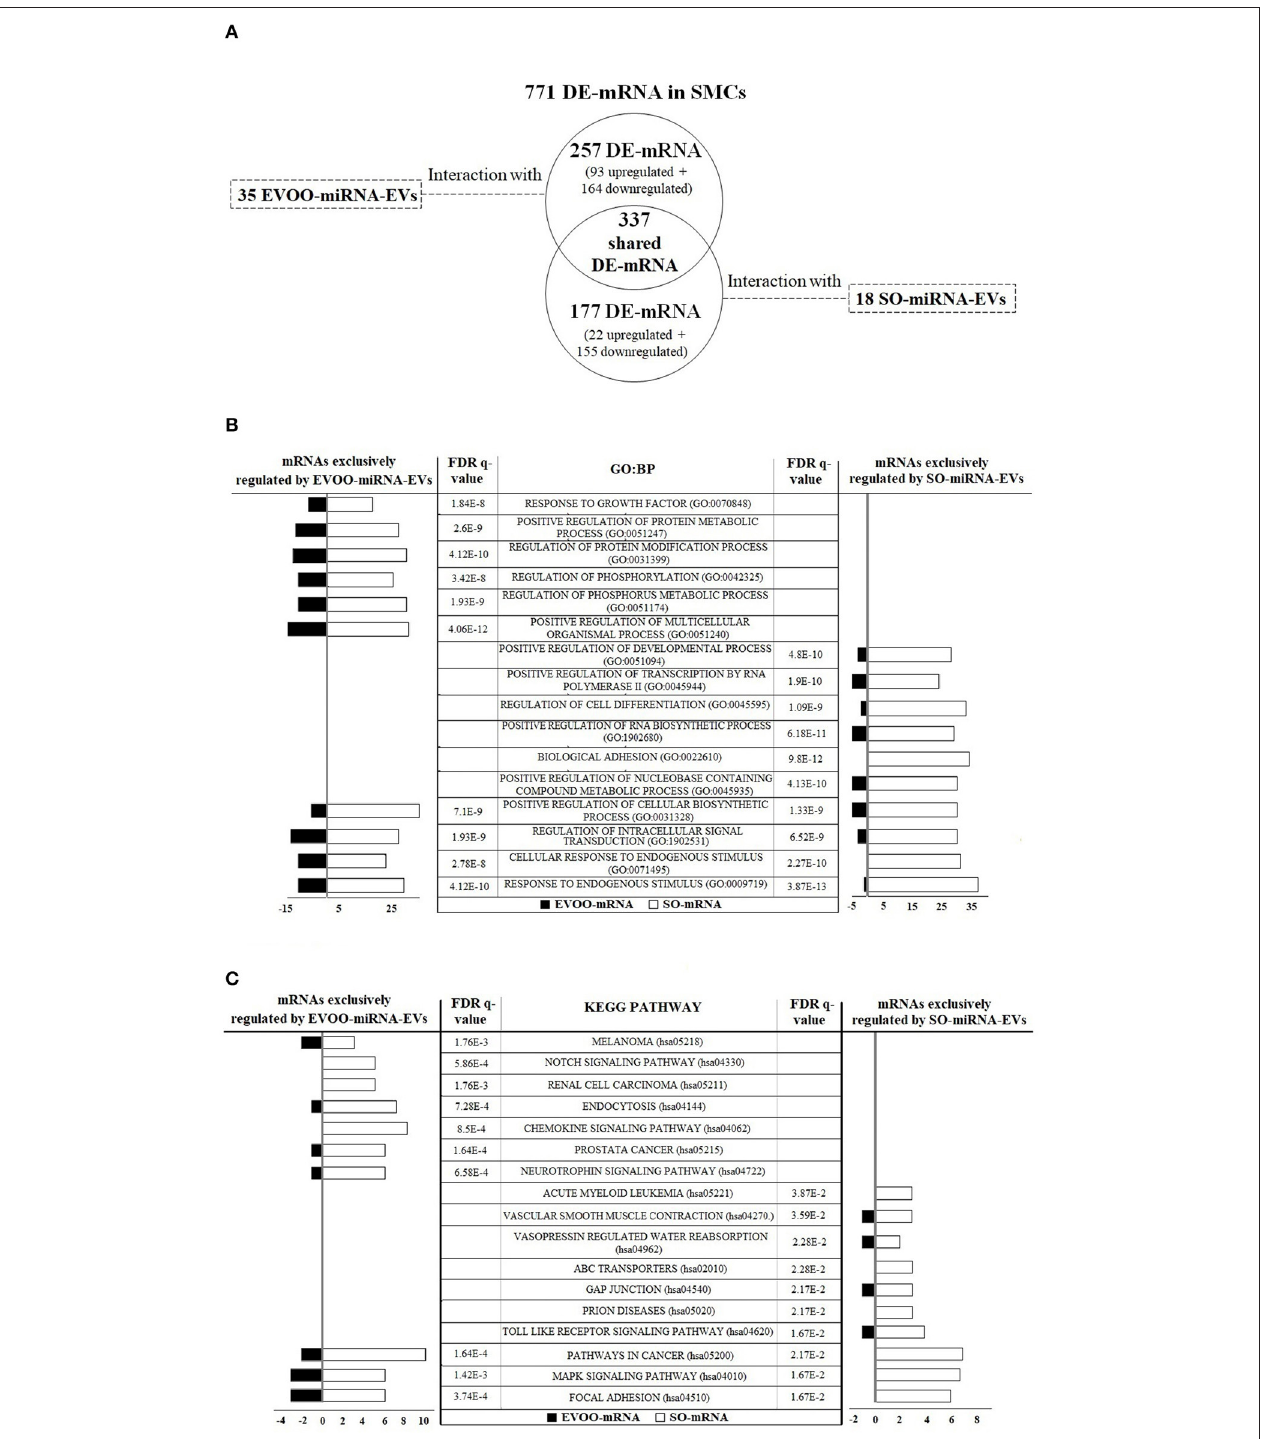
FIGURE 4 | (A) The interaction between the 771 DE-mRNAs found in SMCs and the 53 DE-miRNAs found in EVs was analyzed. Thirty-five upregulated DE-miRNA obtained from EVs secreted by HUVECs incubated with EVOO-derived TRLs (EVOO-miRNA-EVs) could exclusively regulate 257 DE-mRNAs in SMCs (93 up and 164 downregulated EVOO-mRNAs). Meanwhile, 18 upregulated DE-miRNA obtained from EVs secreted by HUVECs incubated with SO-derived TRLs (SO-miRNA-EVs) could exclusively regulate 177 DE-mRNAs in SMCs (22 up and 155 downregulated SO-mRNAs). But 337 DE-mRNAs could be regulated by both EVOO-miRNA-EVs and SO-miRNA-EVs. (B) GO:BP terms found in the 257 DE-mRNA from SMCs that could be exclusively regulated by EVOO-miRNA-EVs and in the 177 DE-mRNA from SMCs that could be exclusively regulated by SO-miRNA-EVs. (C) KEGG pathways found in the 257 DE-mRNA from SMCs that could be exclusively regulated by EVOO-miRNA-EVs and in the 177 DE-mRNA from SMCs that could be exclusively regulated by SO-miRNA-EVs.